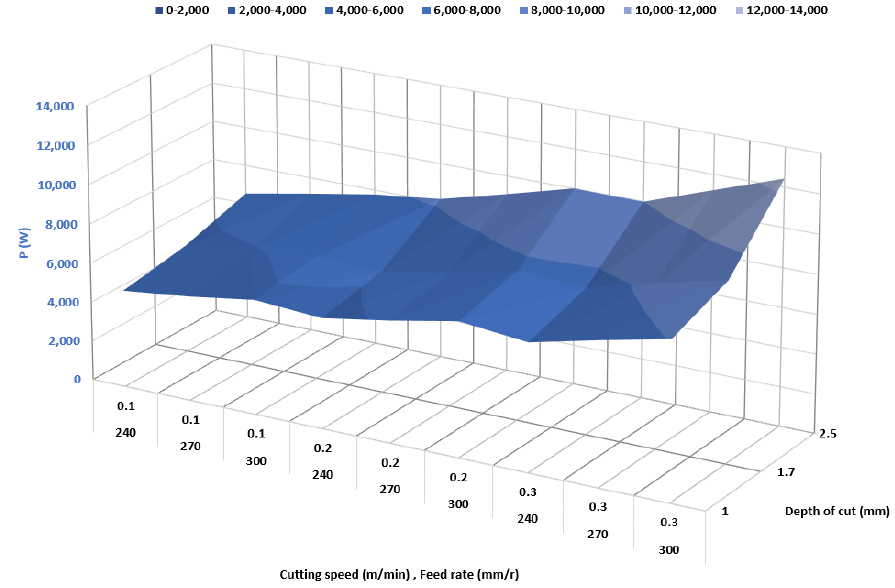
Figure 10. Total engaged power (TEP) in relation to the selected range of a p , f , v c .